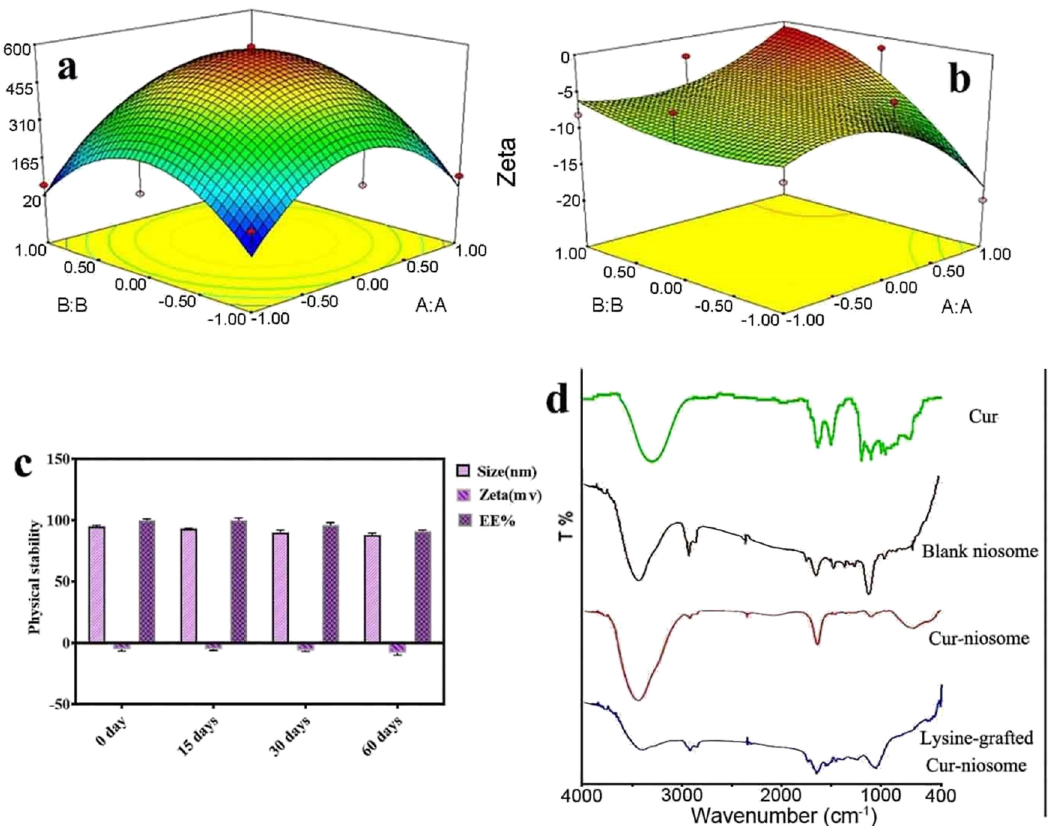
Figure 4: The response surface plot of the ( a ) droplet size and ( b ) zeta potential. ( c ) Physical stability of the modi fi ed niosomal NPs during two months. ( d ) FTIR spectra of Cur, blank noisome, Cur loaded in noisome NPs, and lysine - grafted Cur - niosomal